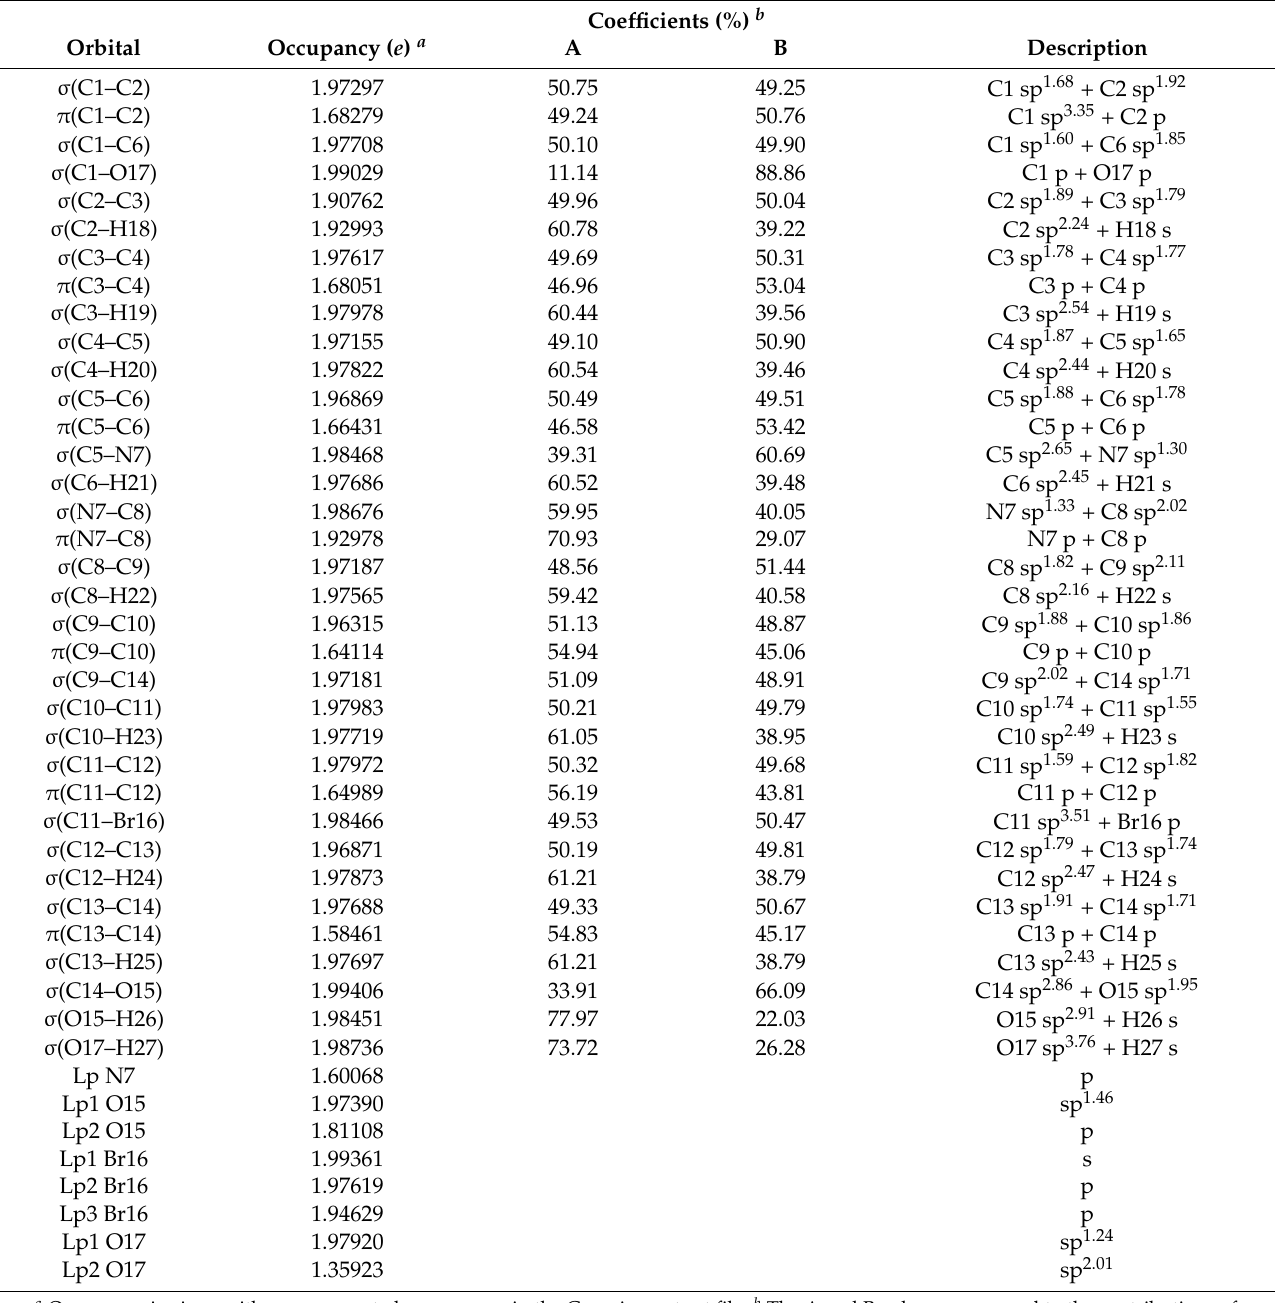
Table 6. Selected (bonding and lone pair occupied) NBOs for E -enol-imine V conformer obtained from the DFT/B3LYP/6- 311++G(d,p)